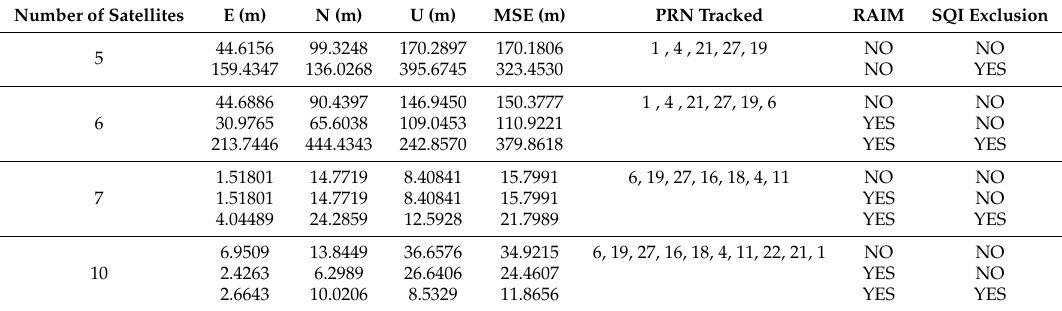
Table 6. Results for the scenario 2 with SQI thres = 0.7 and no penalty weight.